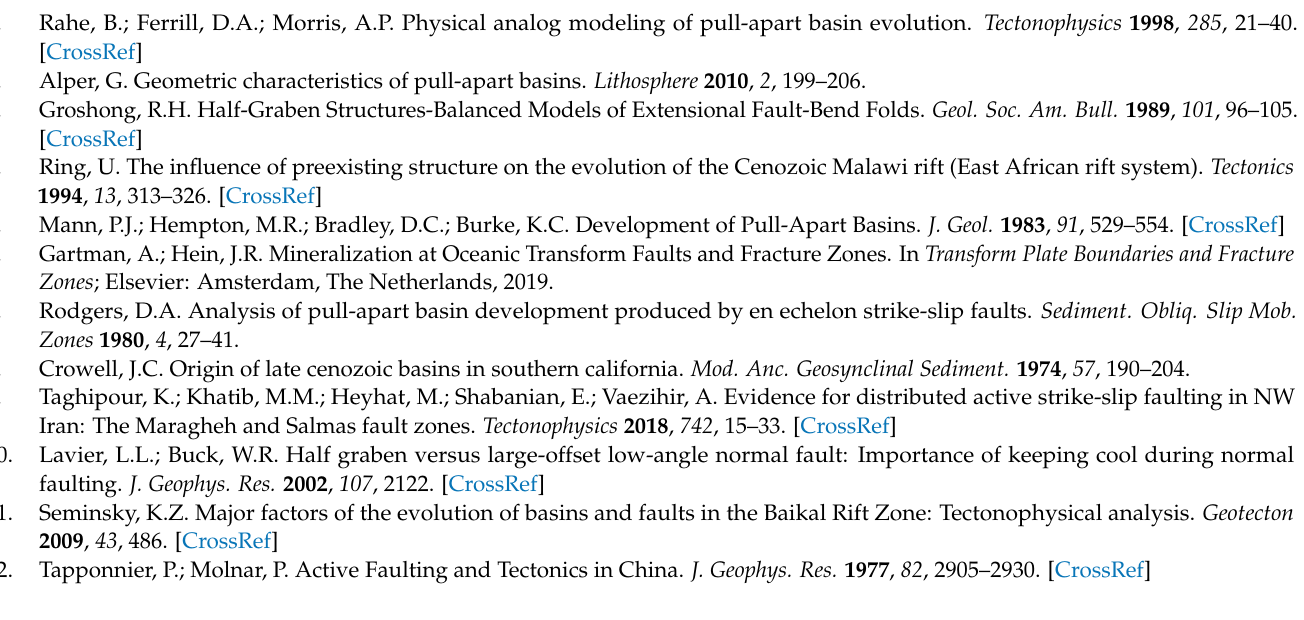
(inhibiting) slips on the receiver faults. Black rectangles show the surface projections of source (MF) and receiver (NHF) fault, respectively, with solid lines showing the upper boundaries; Figure S4: The Coulomb (a,b), normal (c,d), and shear (e,f) stress changes on the NHF fault plane according to Figure S3; Figure S5: The Coulomb (a,b), normal (c,d), and shear (e,f) stress change analyses for dip and strike slips on the NHF based on the Mondy Fault from GAF-DB. The stress changes are calculated at the depths of 11.6 km and 3.2 km, respectively, where the corresponding maximum dip and strike slips occurred in our slip model. The dark-red line represents the fault location of the Mondy Fault. Warm (cold) color means facilitating (inhibiting) slips on the receiver faults. Black rectangles show the surface projections of source (MF) and receiver (NHF) fault, respectively, with solid lines showing the upper boundaries; Figure S6: The Coulomb (a,b), normal (c,d), and shear (e,f) stress changes on the NHF fault plane according to Figure S5; Figure S7: Surface LOS deformation during the 19 January 2021–31 January 2021 obtained from Sentinel-1B SAR satellite; Figure S8: Surface LOS deformation associated with the 2021 Mw5.6 aftershock obtained from Sentinel-1B ascending